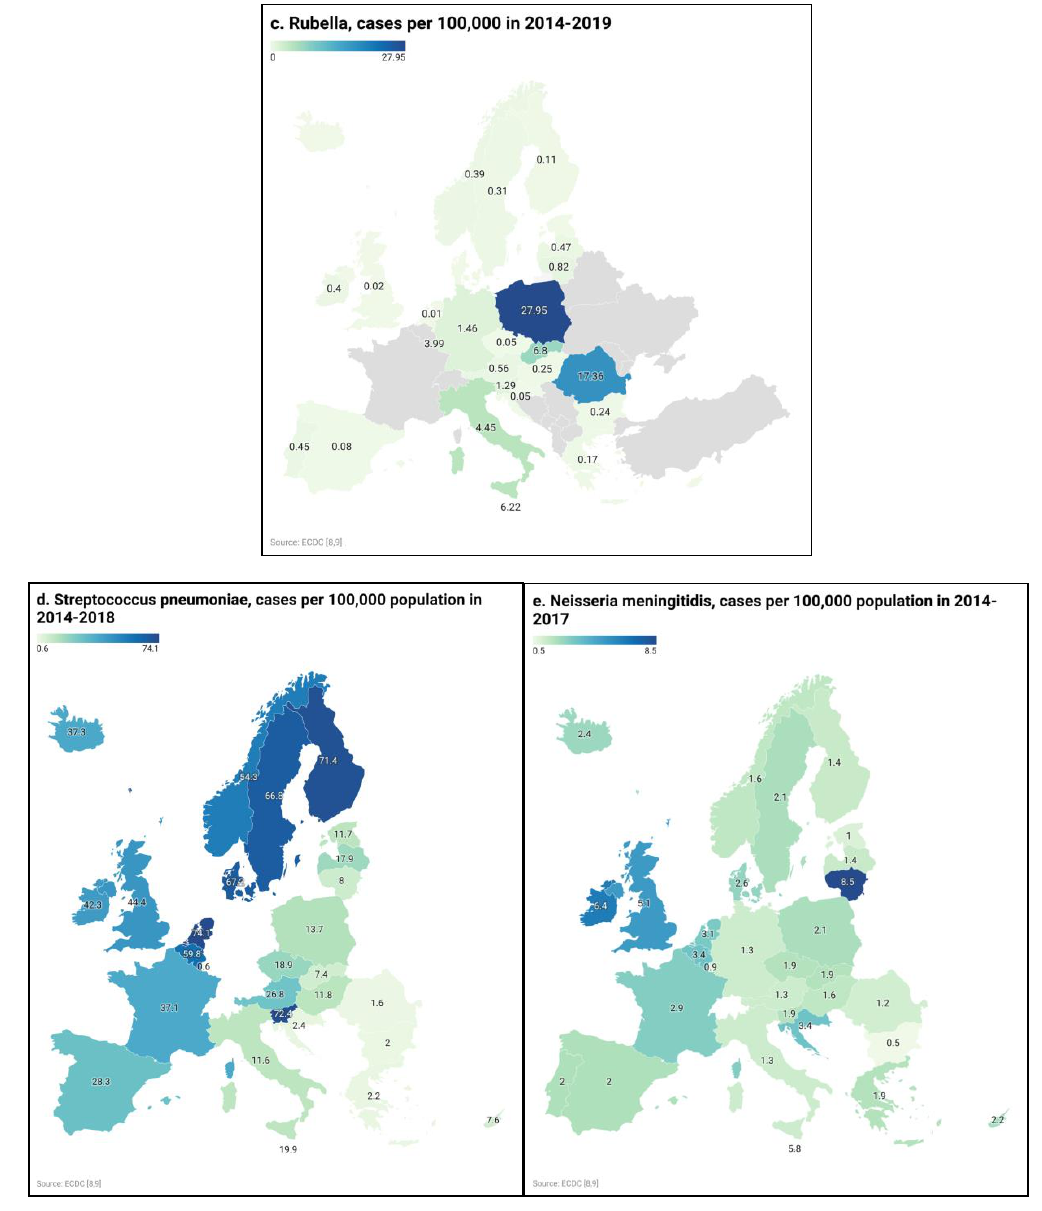
Figure 1. Long-term selected vaccine-preventable childhood diseases incidence rates in the EU and EFTA countries: ( a ) measles (2015–2019), ( b ) mumps (2014–2018), ( c ) rubella (2014–2019), ( d ) Streptococcus pneumoniae (2014–2018), ( e ) Neisseria meningitidis (2014–2017).